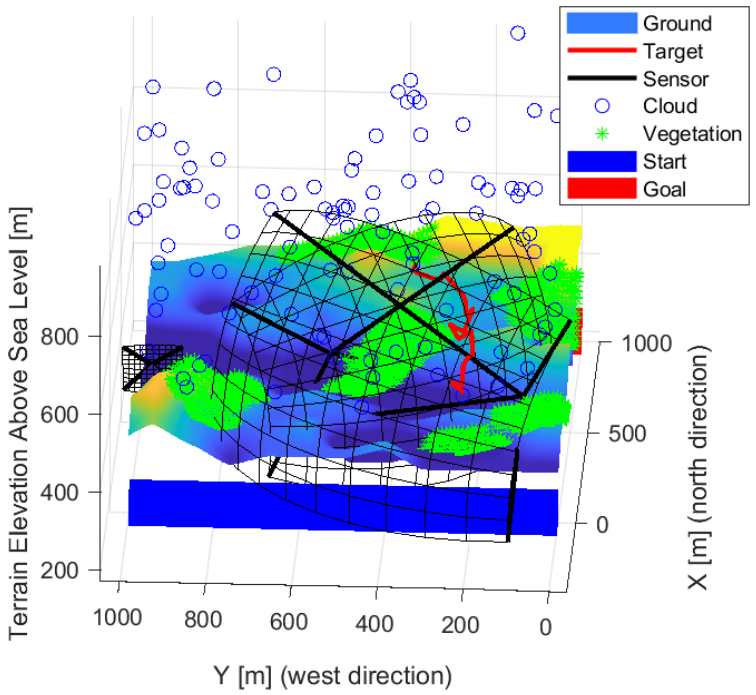
Figure 9. The solution in the case of the three sensors